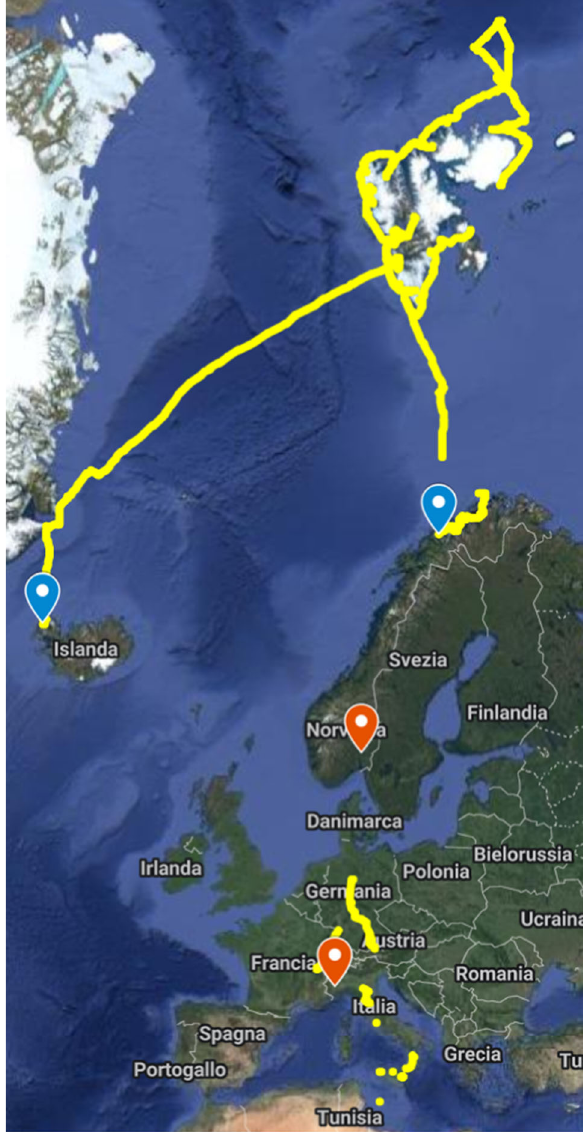
Fig. 1 The trip of POLA-01 (yellow line) as traced by the GPS system. The sites of Ísafjörður (Iceland) and Tromsø (Norway), which were the start and end points of the Nanuq sailing cruise around the Svalbard, are shown with blue markers. The sites of Nesodden (Norway) and Bra (Italy), where the reference detectors POLA-02 and POLA-03 were located, are also shown with red markers